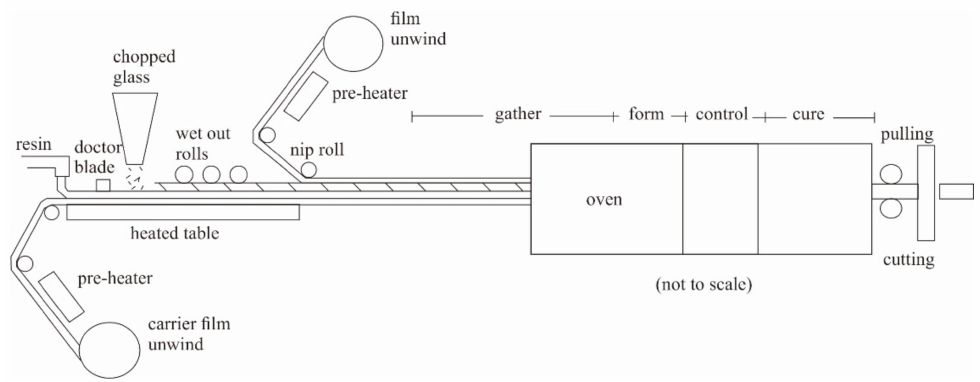
Figure 2. A schematic of continues laminating process.